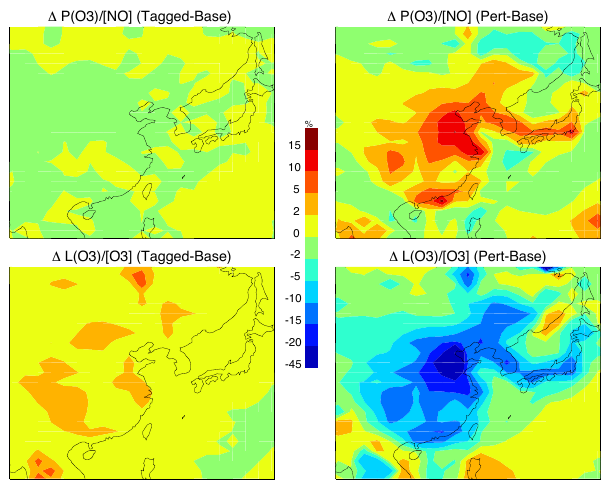
Fig. 11. Differences (%) in K 0 and Base runs (left panels) and between Perturbed and Base runs (right). Average of hourly output for 20–29 July